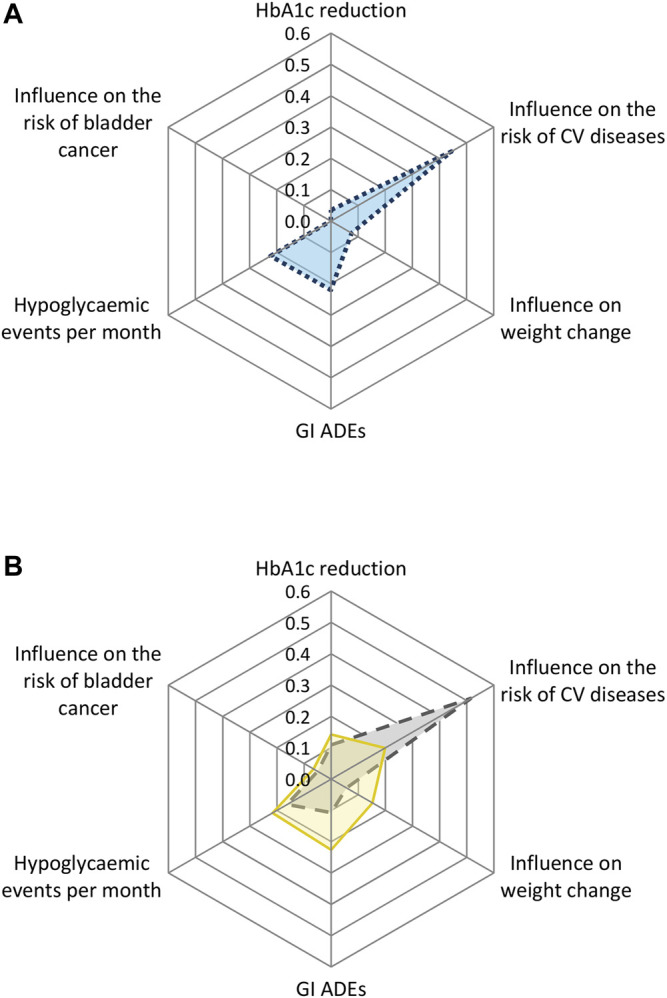
Relative weight scores of the preferences towards the drug attributes of (A) the overall study population and (B) by country for Dutch and Turkish patients. CV = cardiovascular; GI = gastrointestinal; ADEs = adverse drug events.